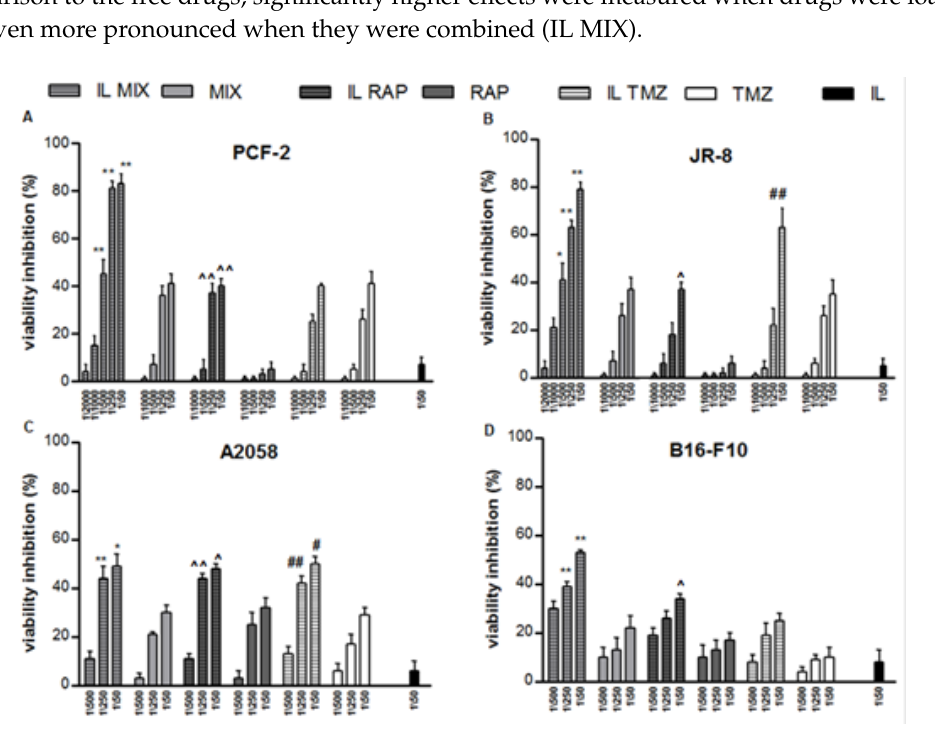
Table 2. iMFI calculated through flow cytometry. IL: Intralipid ® ; FITC: fluorescein isotiocyanate;